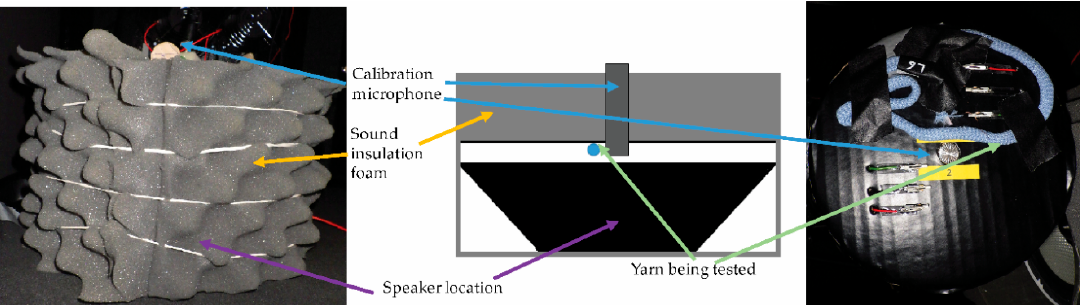
Figure 2. The inner acoustic testing chamber. ( Left ) A photograph of the chamber. ( Middle ) A schematic of the interior of the chamber. ( Right ) A photograph of the lid of the chamber showing the calibration microphone and yarn placements.